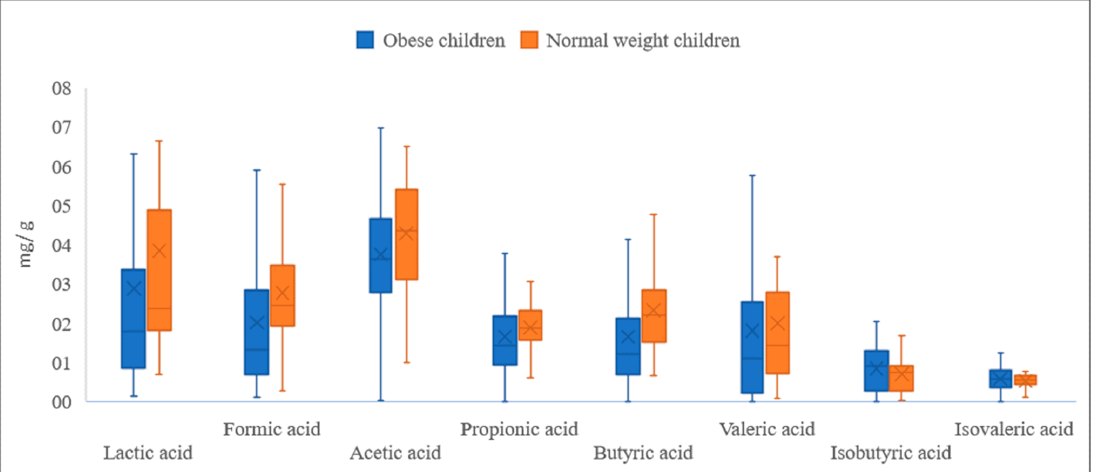
Figure 1. Concentrations of lactic acid, SCFAs, and BCFAs, in obese and normal-weight children.